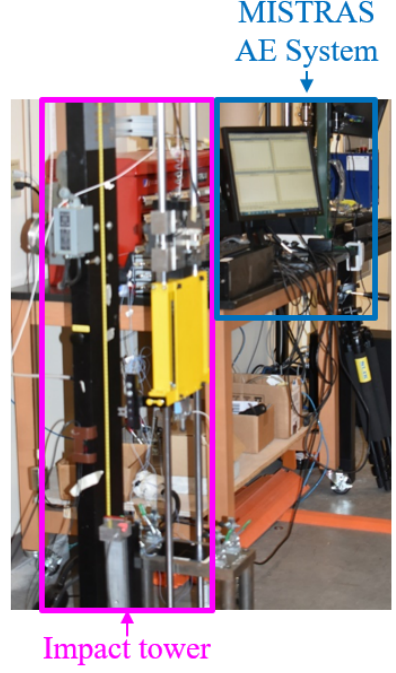
Figure 2. Drop weight impact testing with AE signal capture.